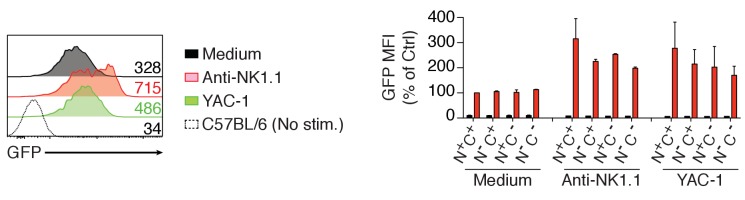
Left: Representative histograms showing the GFP fluorescence levels of Nur77GFP NK cells before or after a 4 hr stimulation with anti-NK1.1 or YAC-1 cells.Non-transgenic C57BL/6 control NK cells are shown. Right: Bar graph showing the GFP levels of the indicated splenic NK cell subsets before or after a 4 hr stimulation with anti-NK1.1 or YAC-1 cells. GFP fluorescence was normalized to the unstimulated N+C+ population of Nur77GFP NK cells (mean +SD, n = 2 mice in two independent experiments).